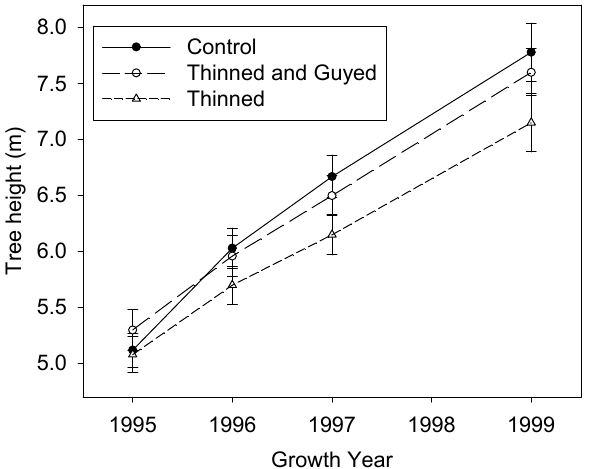
Figure 4. Mean tree height (± standard error) at the end of 1995, 1996, 1997 and 1999 growth years.